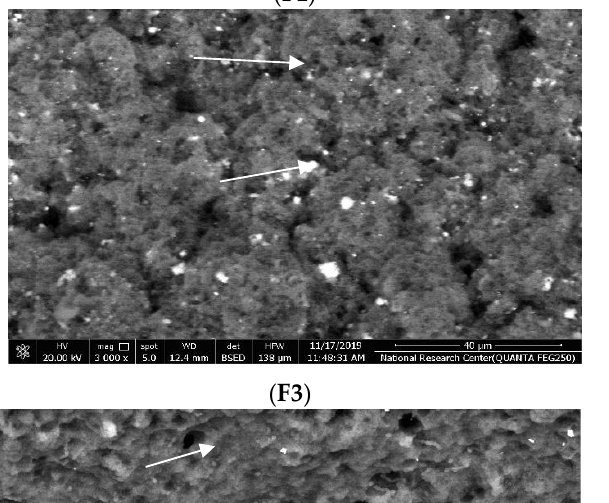
Figure 2. Sensory evaluation of probiotic-frozen yogurt during storage. CA: color and appearance; SC: structure and consistency; TO: taste and odor; IS: icy structure; MM: melt in mouth; GS: gummy structure; TA: total acceptability, F1: Control frozen yogurt; F2: Frozen yogurt with stevia; F3: Frozen yogurt with sucralose; F4: Frozen yogurt with sorbitol; a , b and c : bars and results within the same time frame not sharing a common letter are presented with SE ( p < 0.05).; A and B : bars and results within the same time frame not sharing a common letter are presented with SE ( p < 0.05).